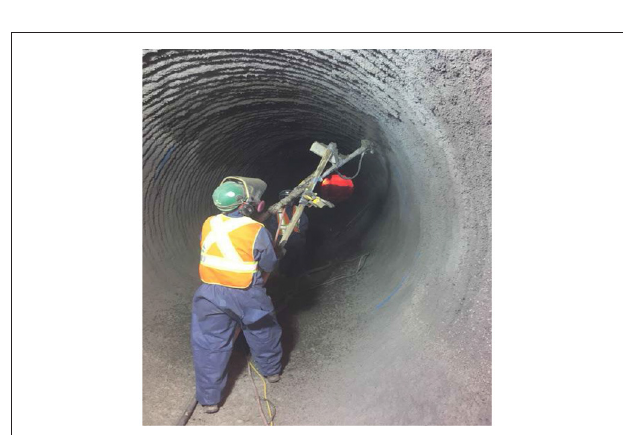
FIGURE 3 | SAPL method used for large conduits. https://www.vector- construction.com/geospray-pipe-and-culvert-lining.